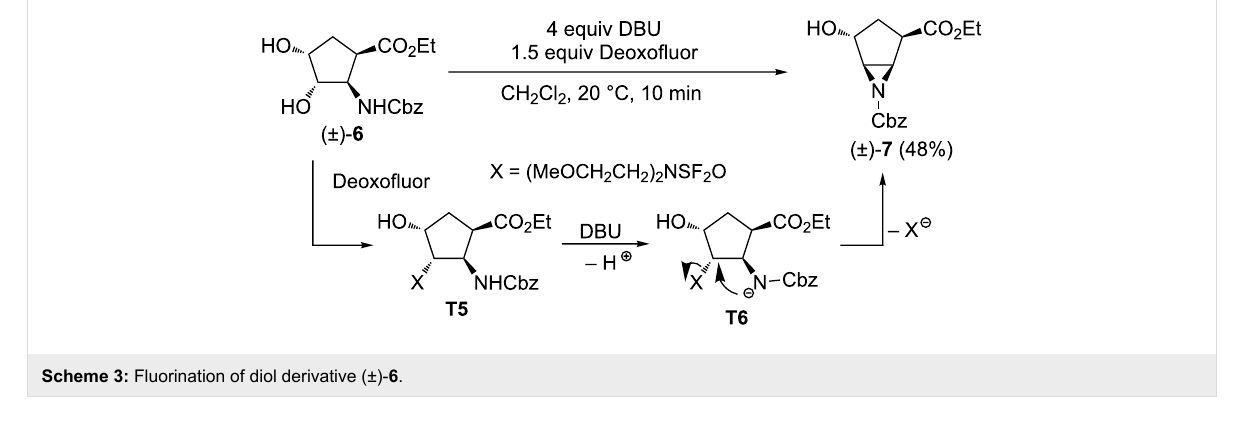
Scheme 3: Fluorination of diol derivative (±)- 6 .